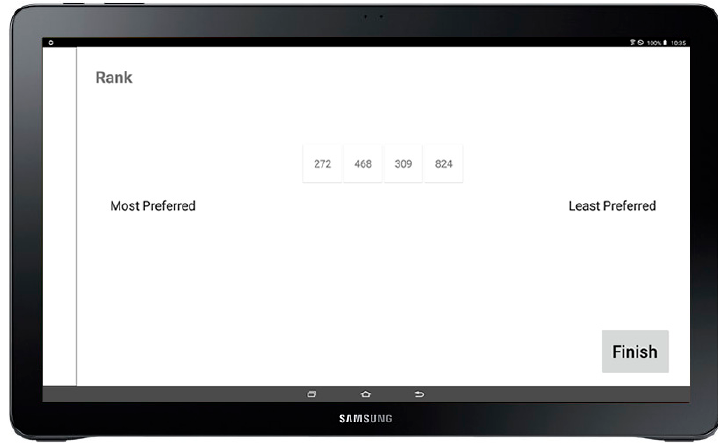
Figure 5. Screen showing the ranking test used to assess preference, ordering samples from most to least preferred.